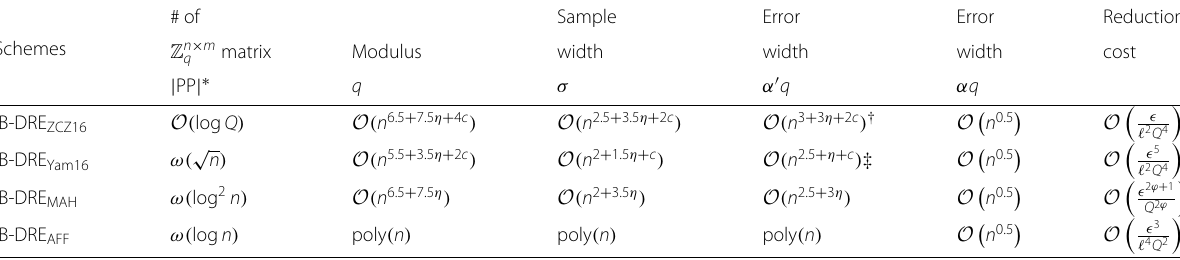
Table 7 IB-DRE schemes from other LPHF with high min-entropy